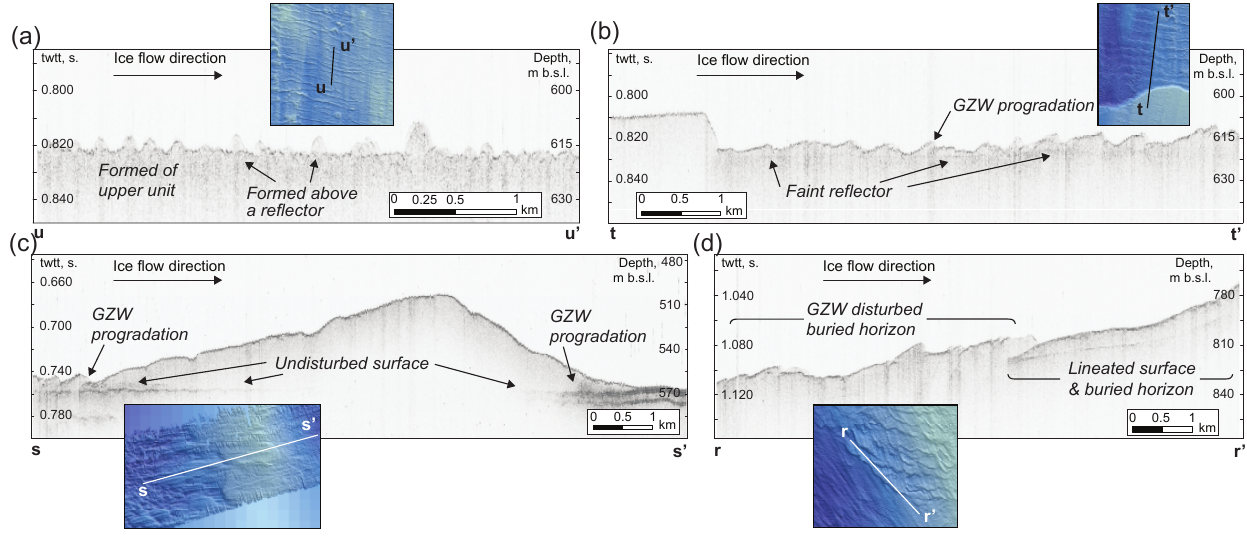
Figure 9. Sub-bottom acoustic data across (a) recessional moraines and (b) grounding zone wedges, where moraines appear to be formed both within the upper unit and above a reflector, and grounding zone wedges are deposited on a faint underlying reflector. (c) A large grounding zone wedge that clearly forms above a reflector and prograded over older strata with younger, smaller grounding zone wedges also showing signs of progradation. (d) Stacked grounding zone wedges appear to have disturbed a buried horizon, implying intense deformation of